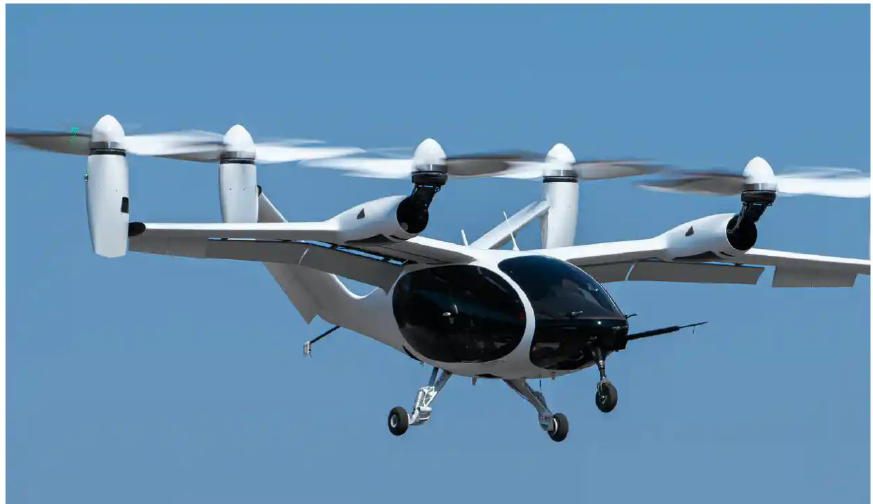
Figure 3. Uber Elevate’s concept eVTOL, intended for operation under the joint complete transporta- tion service with Joby Aviation. Image credit: Uber Air